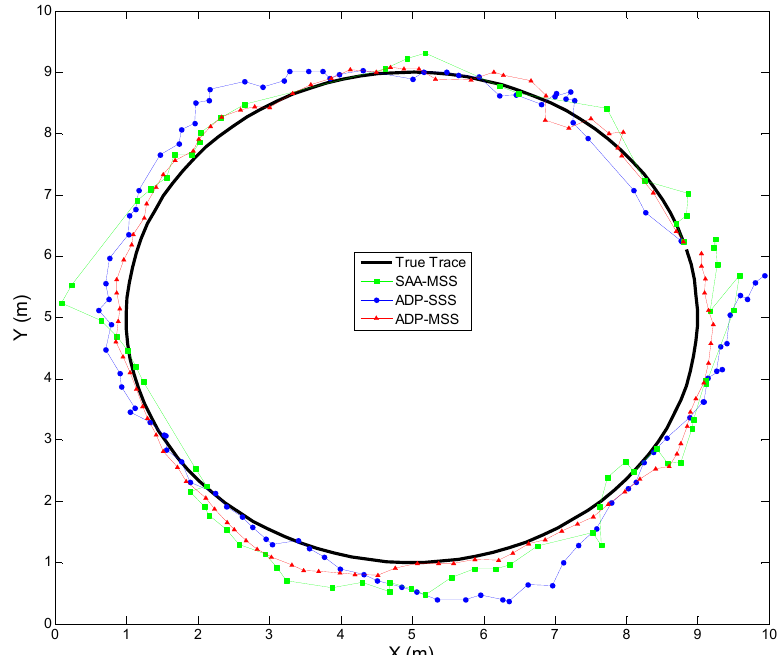
Figure 5. The true trace and estimated trajectories of the target when the variance of the measurement noise was 0.05 and the target speed was 5 m/s. ADP-MSS: ADP-based multi-sensor scheduling algorithm; ADP-SSS: ADP-based single-sensor scheduling algorithm; SAA-MSS: simulated annealing algorithm-based multi-sensor scheduling.